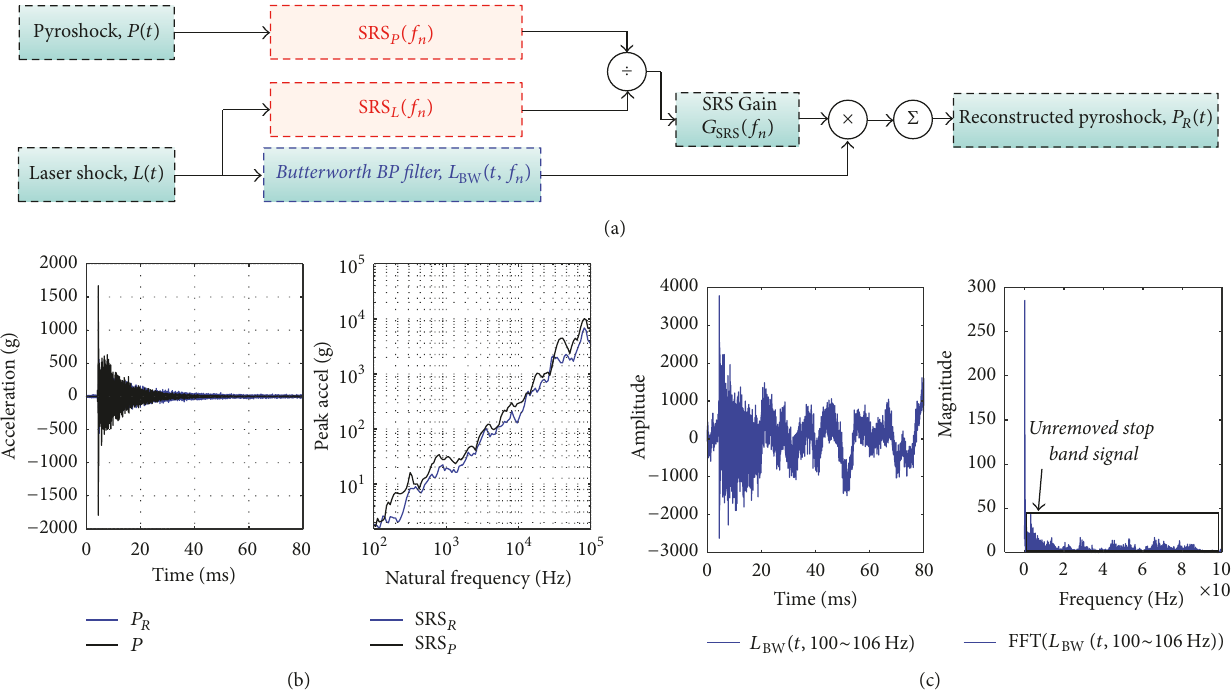
Figure 5: (a) Test algorithm. (b) Reconstruction results of the test algorithm. (c) The problems of test